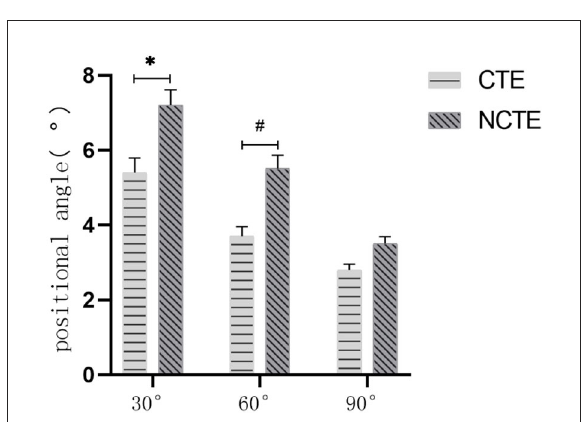
FIGURE7 Proprioception after 4 weeks of treatment: At the end of the 4th week, the angle of the CTE group was smaller than the control group at the 30 ◦ ( P = 0.035) and 60 ◦ ( P = 0.042). There was no statistically significant difference in the positional angle between the two groups at 90 ◦ ( P > 0.05). CTE, cognitive therapeutic exercise; NCTE, no cognitive therapeutic exercise. *indicates a significant difference between the two groups when completing the position perception test with a target angle of 30 ◦ . # indicates a significant difference between the two groups when completing the position perception test with a target angle of 60 ◦